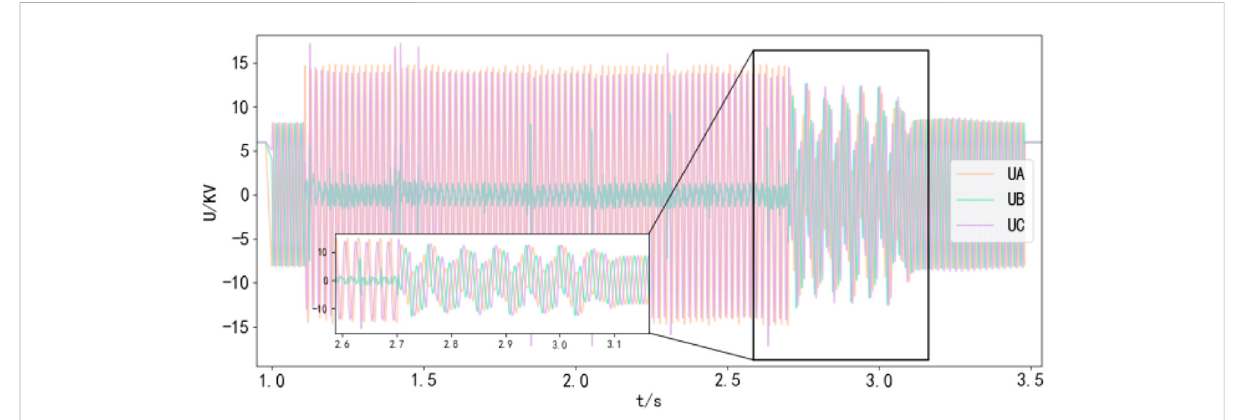
FIGURE 1 Three-phase voltage waveform diagram of developing fault.